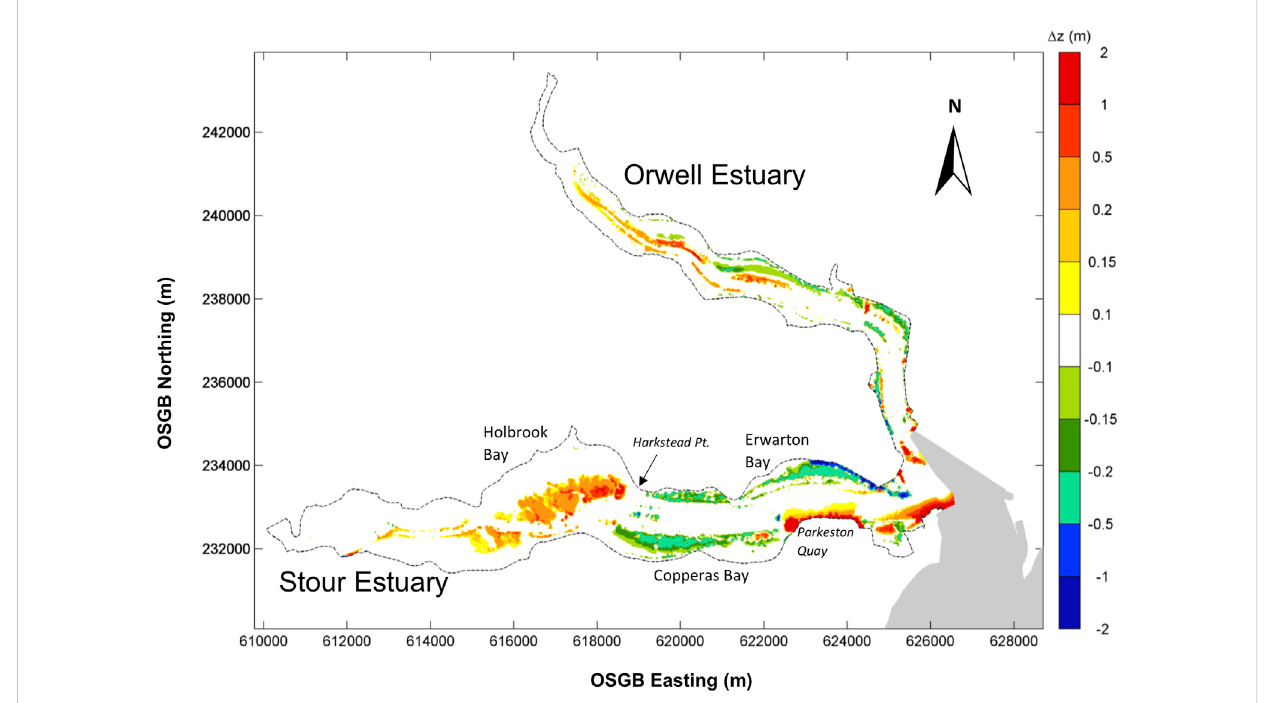
FIGURE 9 Predicted change in the rate of bed level in the Stour and Orwell 2005 –